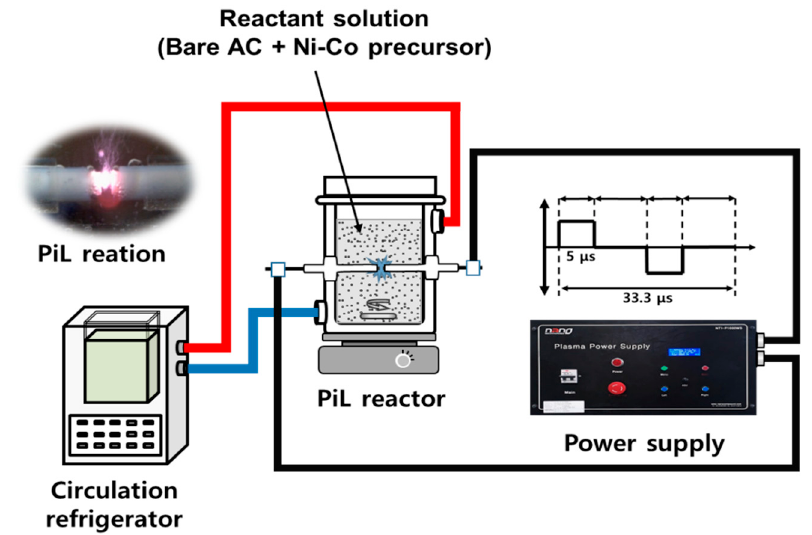
Figure 1. PiLP system schematic and PiL reaction photos used to prepare NCOCCs.